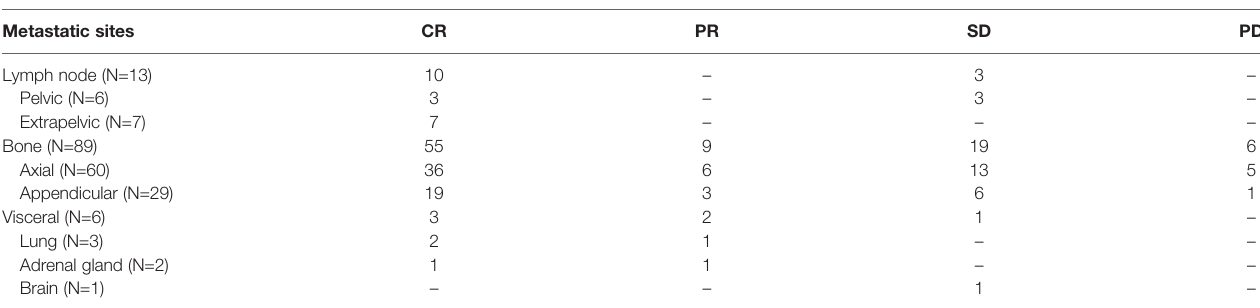
TABLE 3 | Local control following